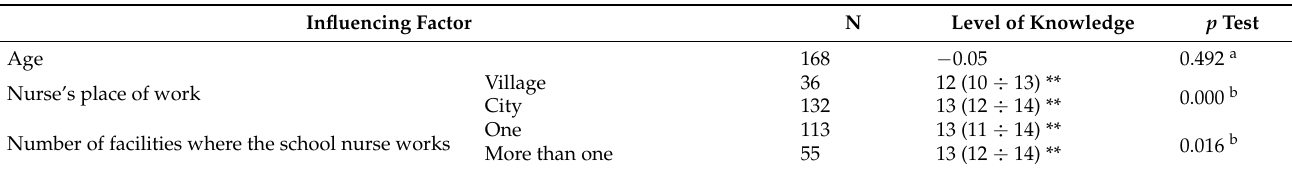
Table 3. Influence of various factors on the level of knowledge of school